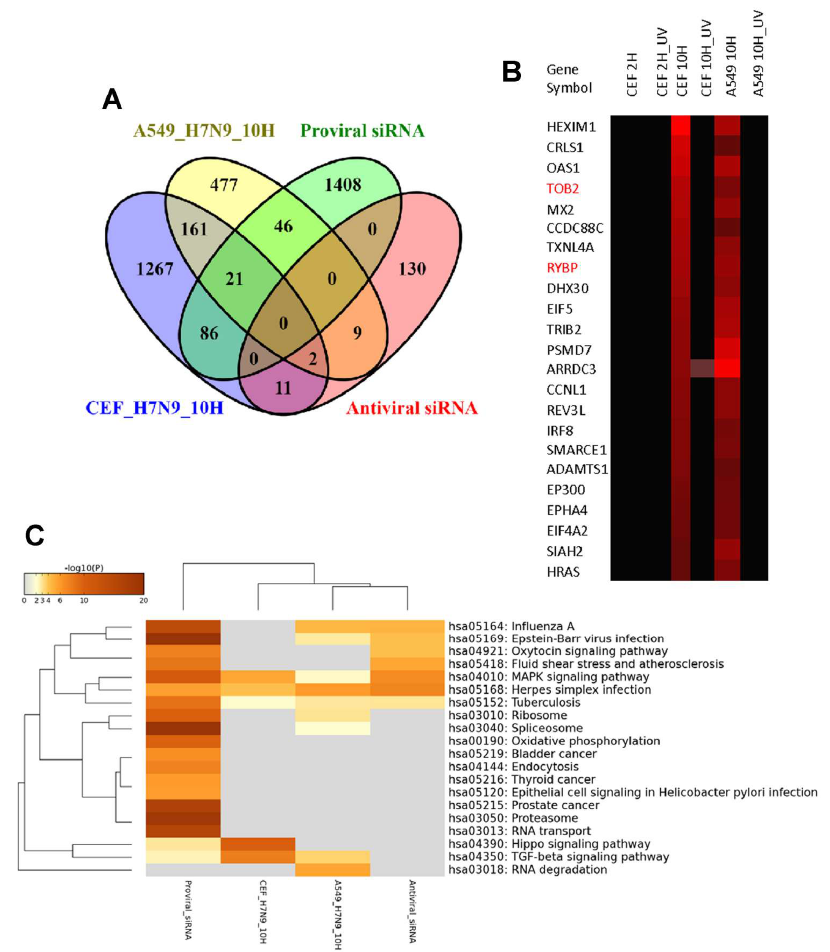
Figure 5. Integration of proviral and antiviral host factors (genes) with the orthologous differentially expressed genes (DEGs) in A549 and CEF cells infected with H7N9 virus. ( A ) Pairwise analysis of the DEGs with proviral and antiviral host factors from siRNA screening studies. ( B ) Heat map representing 21 proviral and 2 antiviral host factors (gene symbols highlighted in red) up-regulated in both virus-infected A549 and CEF cells. ( C ) Functional annotation of proviral and antiviral host factors from siRNA studies in line with up-regulated DEGs in virus-infected A549 and CEF cells at 10 hpi.